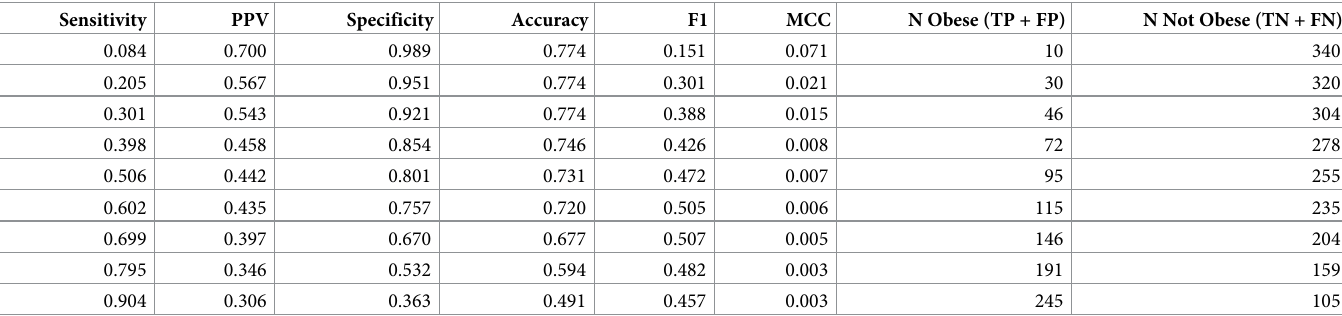
Table 7. Performance tradeoffs for the best performing model for boys. Sensitivity